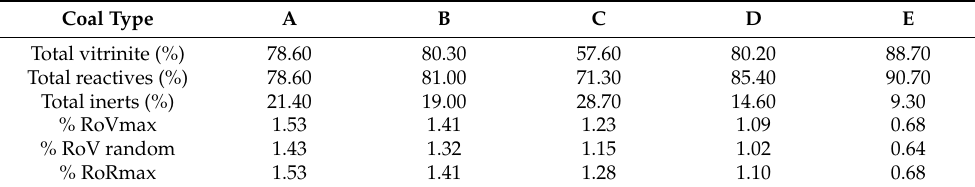
Table 2. Coal petrography results.